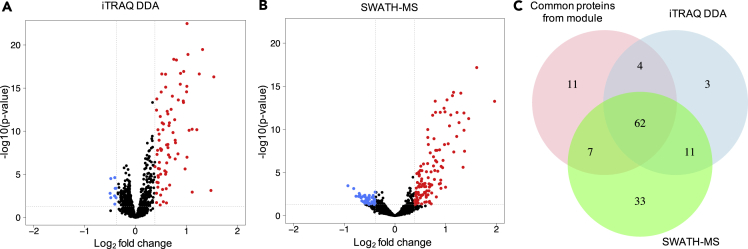
Group Comparison of Proteins in Mesenchymal Subtype versus the Non-mesenchymal SubtypesUp-regulated proteins among the Mesenchymal subtype tumors are indicated in red and the down-regulated proteins are indicated in blue. The fold-change cutoff was 1.3, and the significance cutoff was p < 0.05.(A) iTRAQ DDA data.(B) SWATH-MS data.(C) Comparison of all proteins assigned to the ECM module based on the original proteomic classification (Zhang et al., 2016a) versus proteins assigned to the ECM module in the iTRAQ DDA data and the SWATH-MS data.